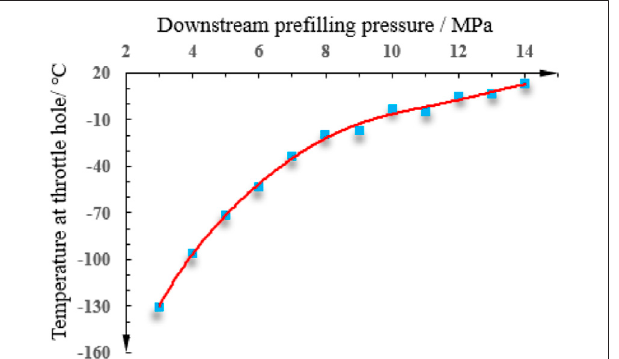
FIGURE 7 | Temperature curve of throttling at different pre fi lling